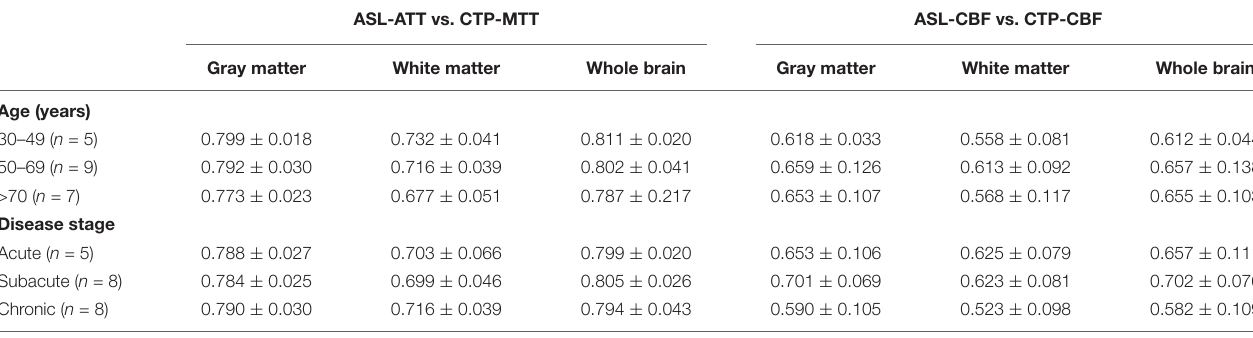
TABLE 4 | Mean Pearson correlation coefficients of different subgroups between the two modalities in gray, white matter and whole brain. ASL-ATT vs. CTP-MTT